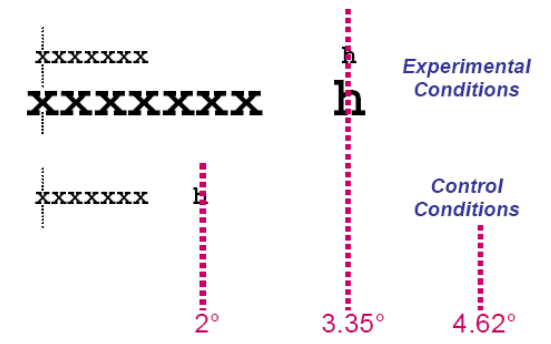
Figure 2. Example stimuli in our character-size experiment. The saccade target stimulus was an isolated letter (‘h’ in the example) and the distractor was an x-letter string of a variable number of letters. The angular size of the characters was either small (.22°) or large (.42°). In the experimental conditions, the eccentricity of the target letter was maintained constant (3.35°). In the control conditions, it was smaller for small characters (2°), and larger for large characters